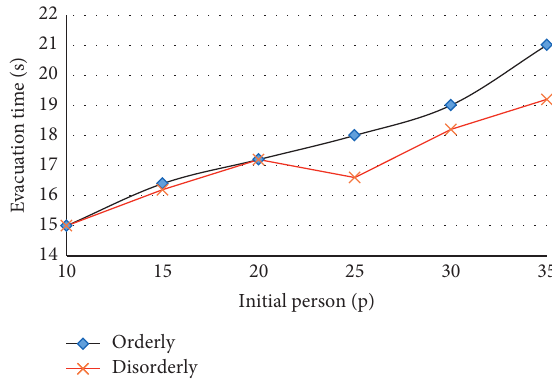
Figure 7: Contrast of evacuation time between different gathering modes and